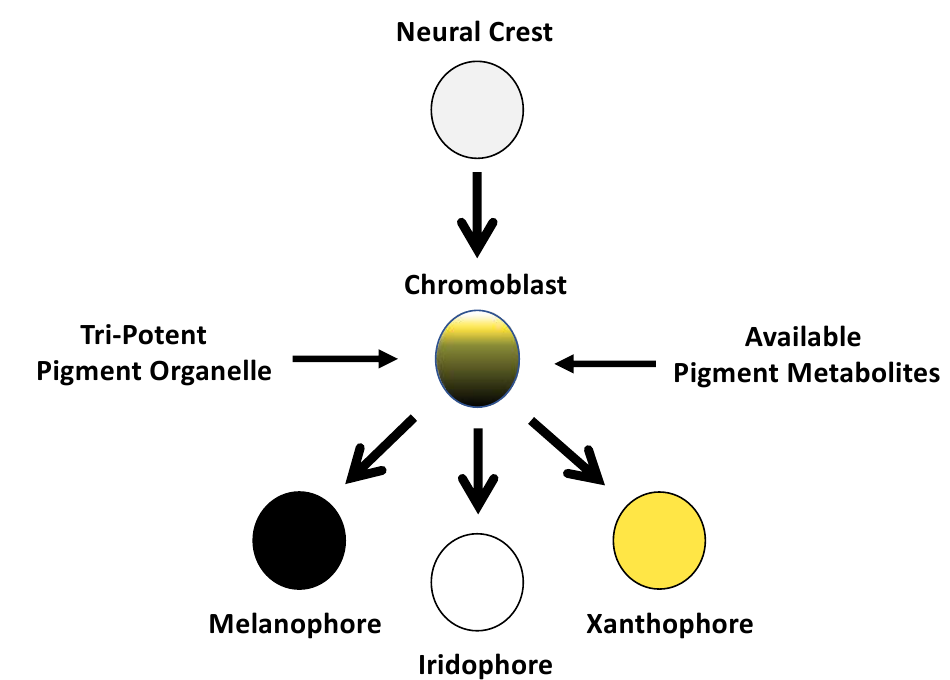
Figure 2. Schematic depiction of the single-origin hypothesis for pigment cells originally proposed by Bagnara et al. [8]. The three primary pigment cell types arise directly from a neural-crest-derived progenitor cell (chromoblast) with a tripotent pigment organelle. Fate specification of the chromoblast is determined by genetic and environmental factors that affect the formation of pigment-producing organelles. According to this hypothesis, melanophores permissively differentiate in melanoid axolotls because multipotent pigment progenitor cells have reduced XDH activity and lower levels of purine and pterin pigments that are synthesized by organelles of iridophores and xanthophores, respectively. Since the proposition of a single-origin basis for pigment cells, pigment cell differ- entiation has been studied intensively using teleost fish, especially the zebrafish. Many genes have been identified that function in the specification of pigment cell fates, such as the requirement of melanocyte inducing transcription factor ( Mitf ) for melanophores [9] and leukocyte tyrosine kinase ( Ltk ) for iridophores [10]. In contrast to the single-origin model of pigment cells, studies of zebrafish have revealed a more progressive process of differentiation involving intermediate progenitor cells that arise from a neural-crest- derived progenitor. For example, a bipotent precursor has been proposed for the origin of melanoblast and iridoblast intermediate progenitors that, in turn, originate melanophores and iridophores, respectively [10]. The overall process of progressive fate specification is largely controlled by genetic factors that act autonomously within cells, although cell fate is also influenced by environmental factors, including temporal and spatial